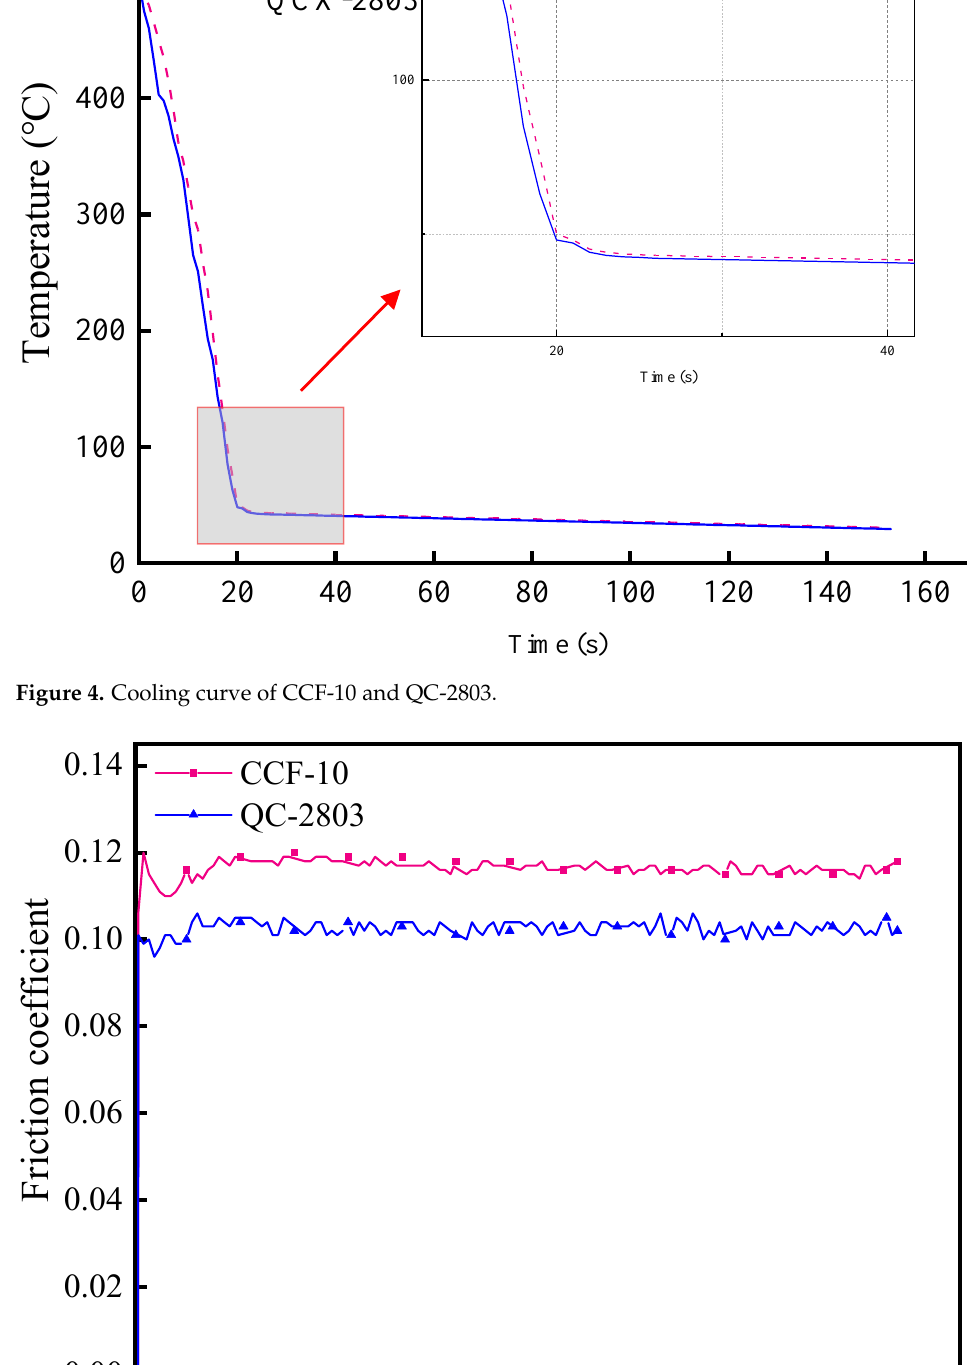
Figure 4. Cooling curve of CCF-10 and QC-2803.